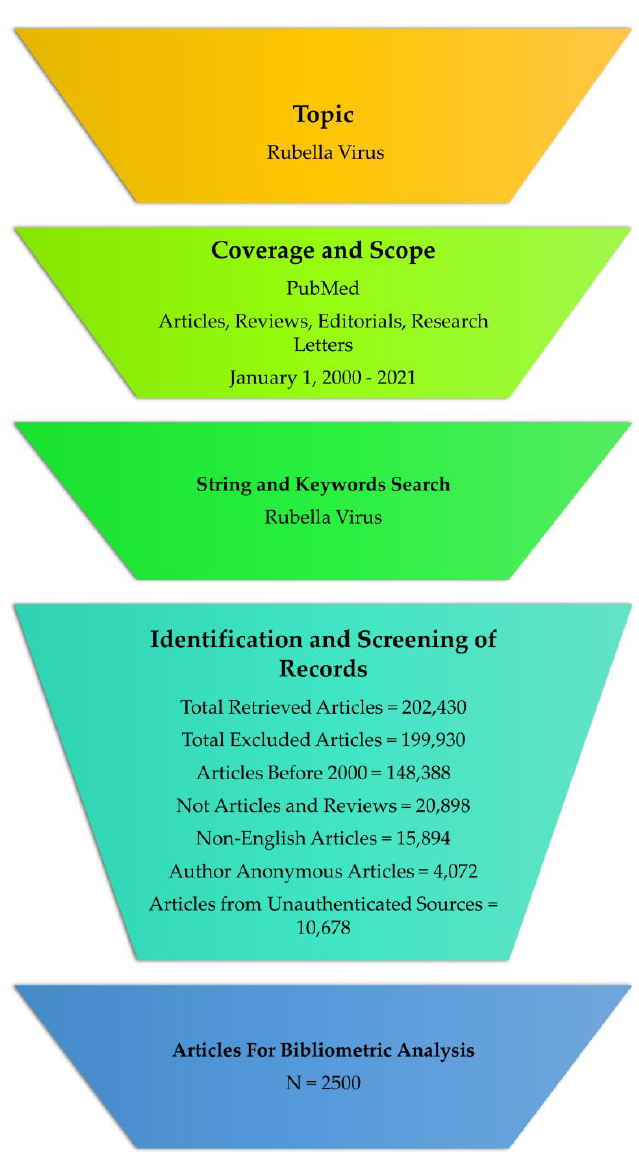
Figure 1. Procedure for selecting appropriate articles.